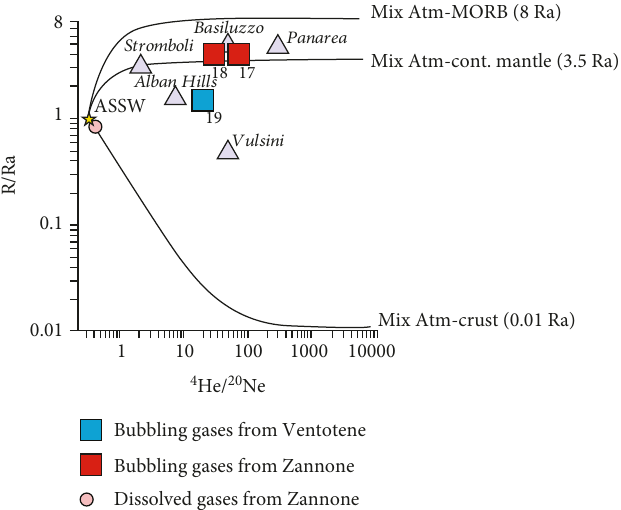
Figure 6: Helium isotopic ratios (as R/Ra) and 4 He/ 20 Ne relationships. The theoretical black lines represent binary mixing trends for atmospheric helium with helium from crust and mantle sources. The assumed end-members are ASSW (yellow star) with Ra = 1 and He/Ne ratio = 0 267 ; crust with R/Ra = 0 01 and 4 He/ 20 Ne = 5000 ; MORB-type mantle with R/Ra = 8 and 4 He/ 20 Ne = 1000 ; contaminated mantle by crustal fl uids due to subduction of continental crust having Ra = 3 5 and 4 He/ 20 Ne = 1000 . Data for bubbling gases from Panarea and Basiluzzo [16], Stromboli [60], Vulsini [61], and Alban Hills [62] are plotted for